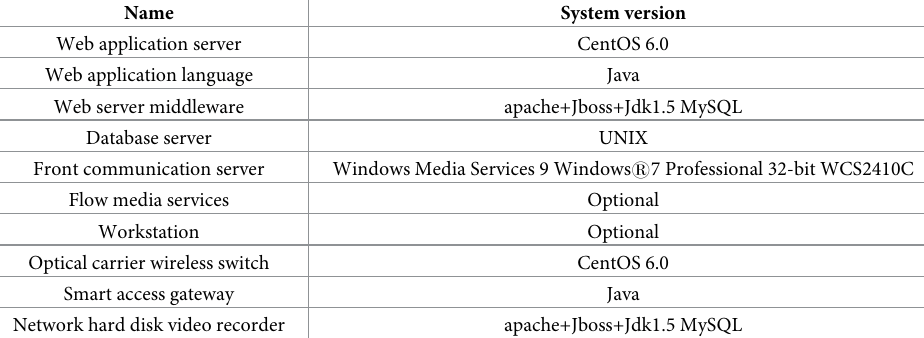
Table 1. Configurations for test environment of smart classroom